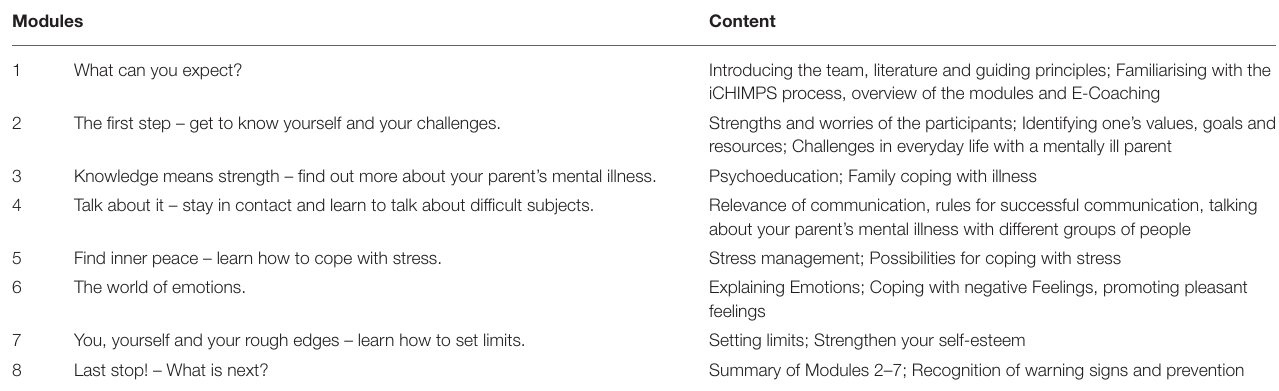
TABLE 1 | Overview of intervention modules.